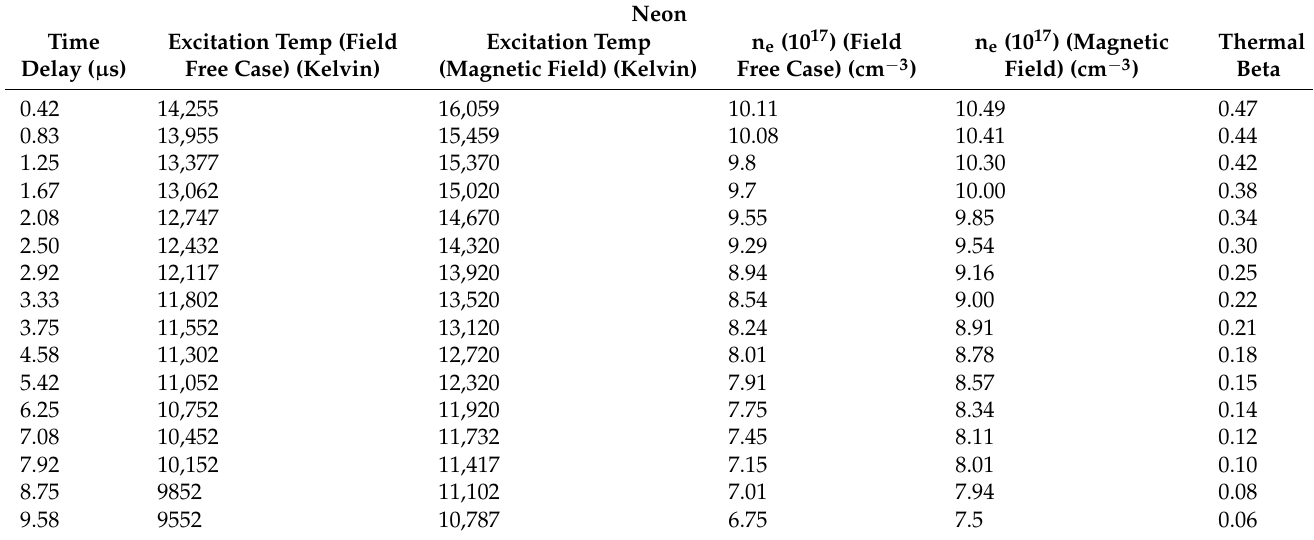
Table 6. Evaluated values of excitation temperature, electron number density, and thermal beta for LPP of Mg under Ne environment at different time delays with and without TMF.